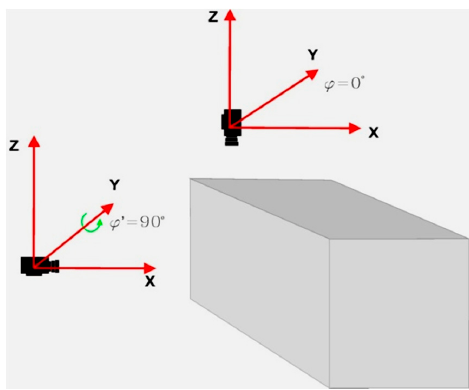
Figure 1. Transition of the video camera mounted on the UAV from aerial to terrestrial orientation.